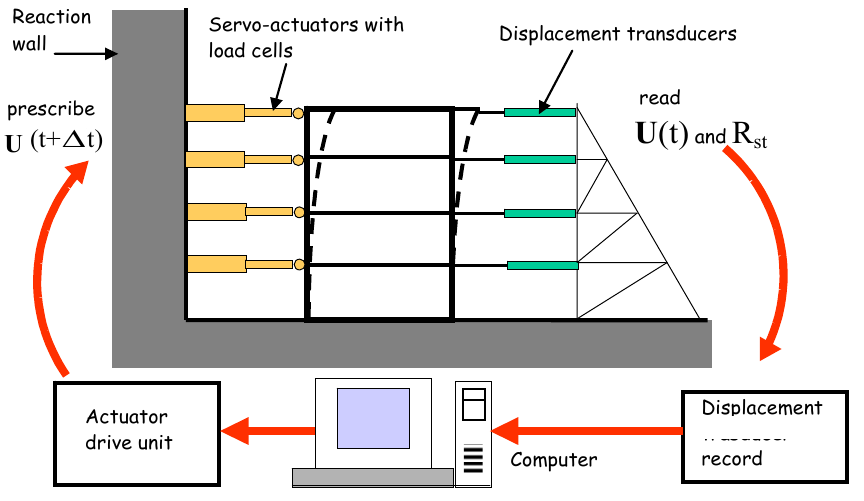
Figure 7. Operation diagram of a closed-loop pseudo-dynamic procedure.